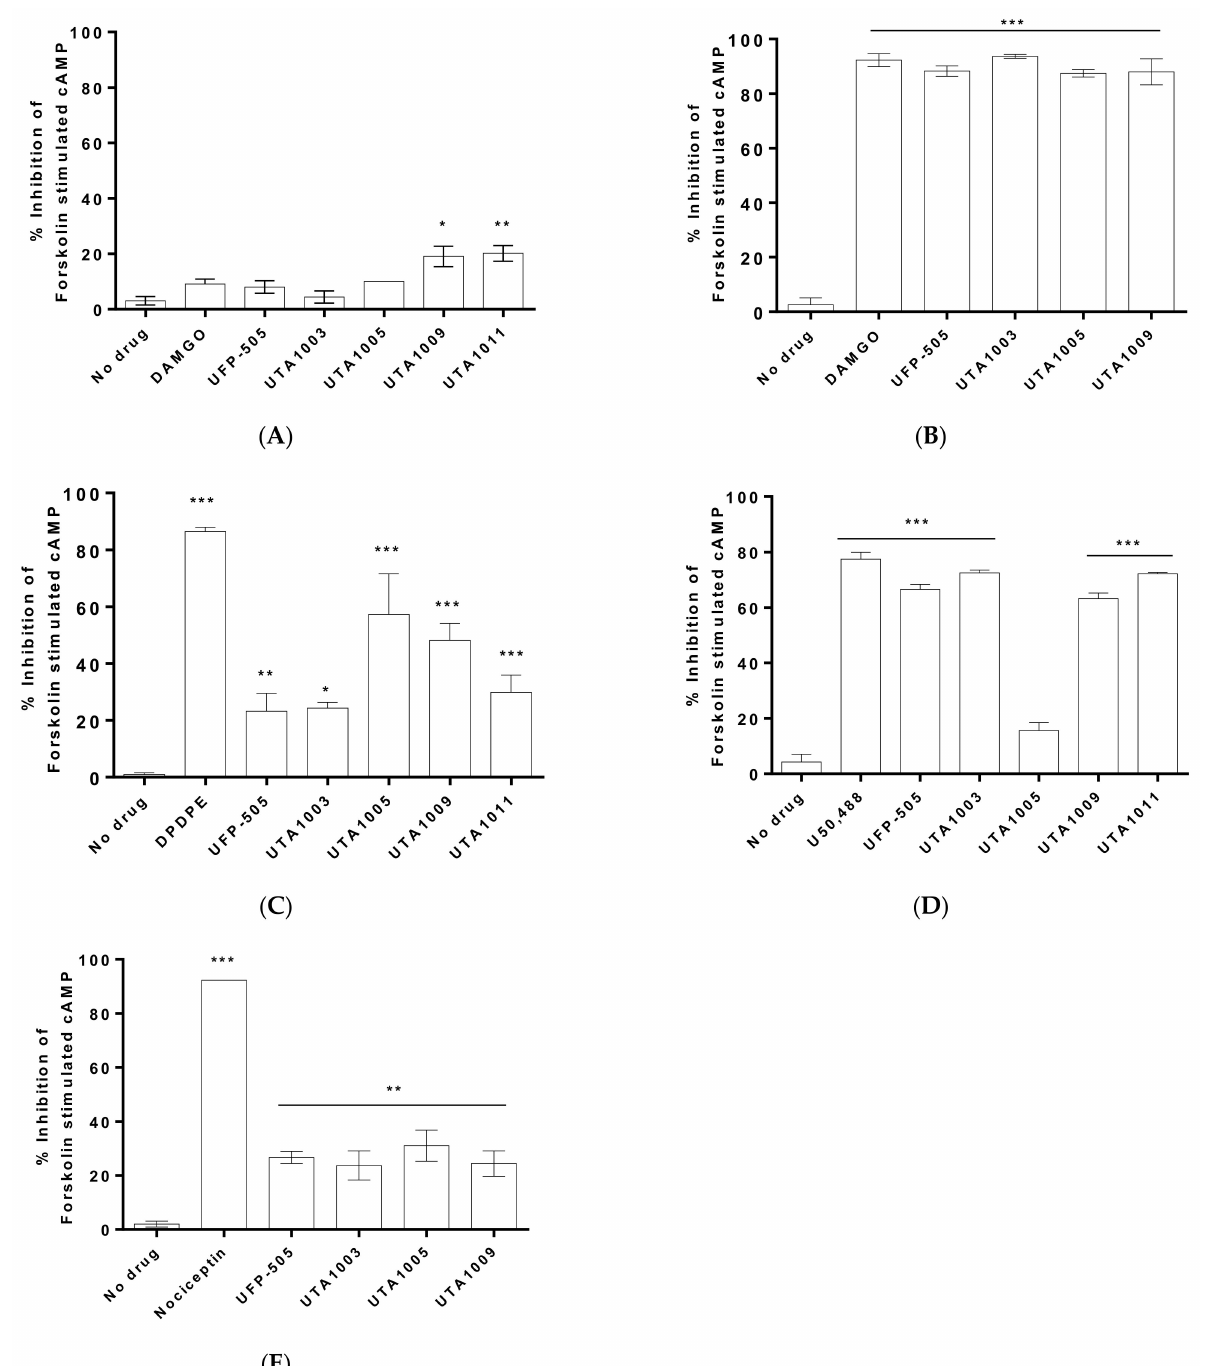
Figure 2. Effects of UTA-opioids on wild-type ( A ), µ -opioid receptor ( B ), δ -opioid receptor ( C ), κ -opioid receptor ( D ), nociceptin/orphanin-FQ receptor ( E ) expressing Chinese hamster ovary (CHO) cells. Inhibition of forskolin-stimulated cAMP levels was measured in the absence or presence of 100 µ M UTA and reference opioids. Statistically significant differences against the effect of 1 µ M forskolin (no drug) is expressed as * ( p < 0.01), ** ( p < 0.001), or *** ( p < 0.0001) and were calculated using one-way ANOVA with Bonferroni’s multiple comparisons test. Values represent the mean ± SEM (n = 6 wells per group). Error bars are present in all graphs but are sometimes too small to be